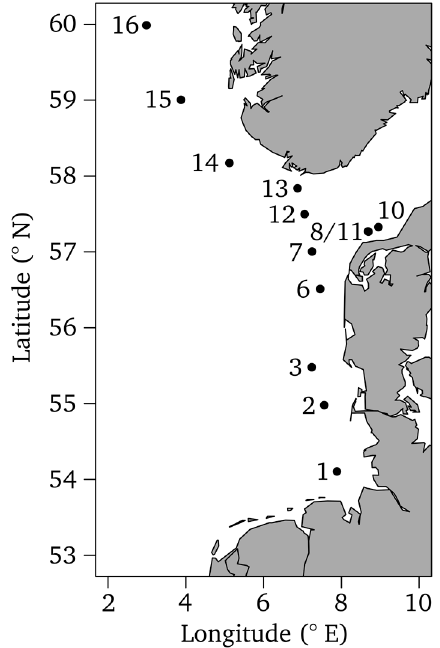
Figure 1. Map of the North Sea showing all samplings sites. Note that numbering follows ship stations. Stations 4, 5, and 9 are missing because no water samples were taken at these stations. Samples 8 and 11 were taken close to each other and are visualized as one station. The map was generated in [24] using the maps and mapdata packages [25,26].